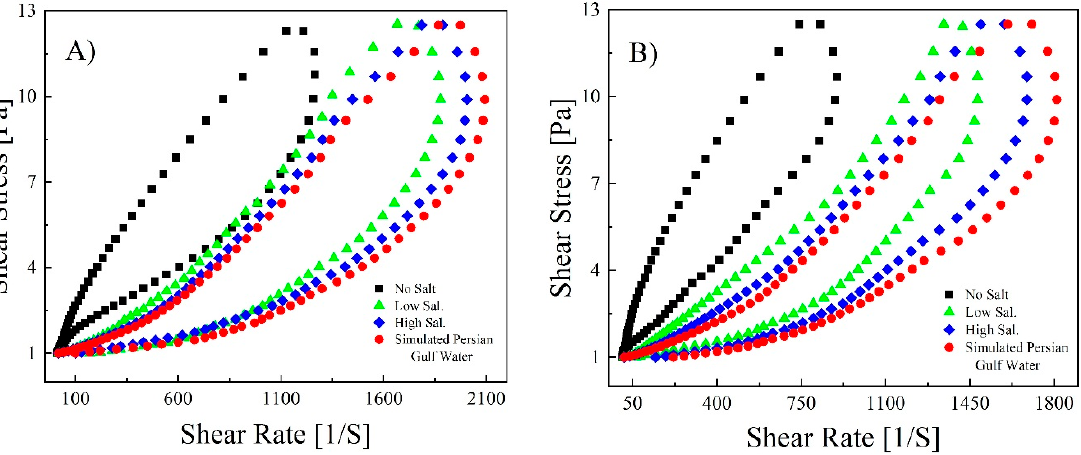
Figure 8. Thixotropic curves of Flopaam 3630S polymer solution at a concentration of 1000 ppm ( A ) and 1500 ppm ( B ) at different salt concentrations.